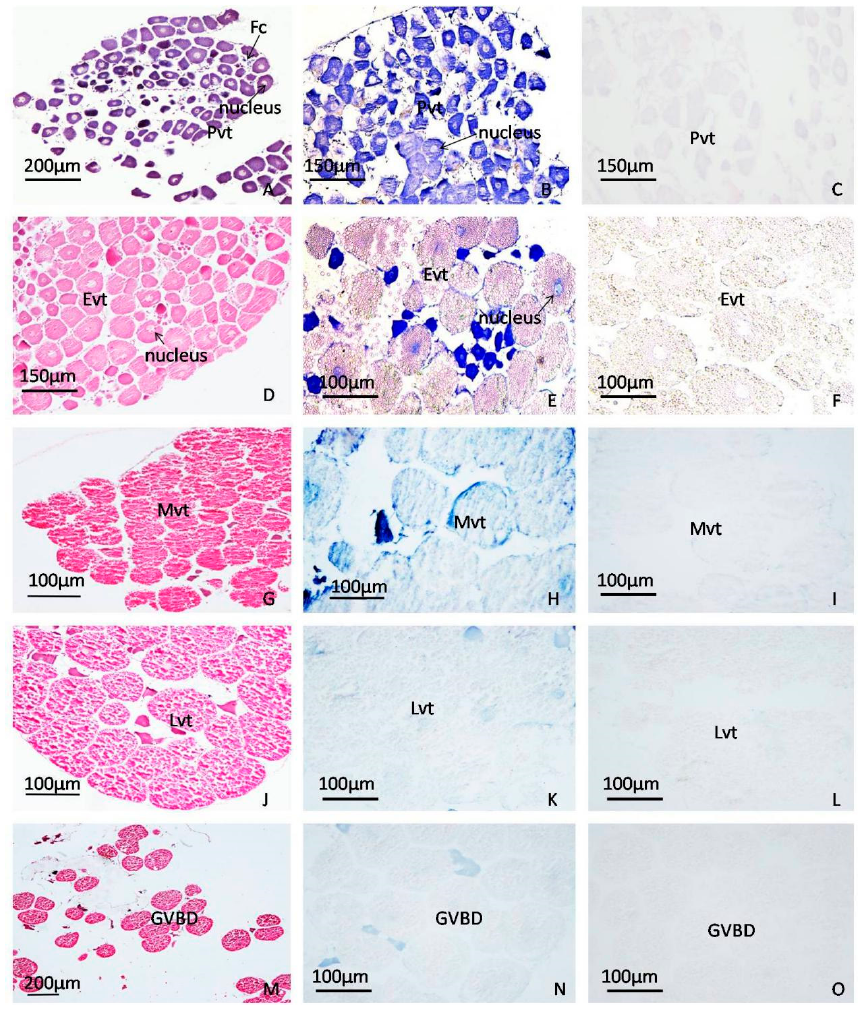
Figure 5. In situ hybridization (ISH) localization of EsLHR mRNA in the ovaries at various stages. ( A – C ), previtellogenic stage (Pvt); ( D – F ), early vitellogenic stage (Evt); ( G – I ), middle vitellogenic stage (Mvt); ( J – L ), late vitellogenic stage (Lvt); ( M – O ), germinal vesicle breakdown stage (GVBD). A, D, G, J, and M, HE staining; B, E, H, K, and N, ISH using antisense probes; C, F, I, L, and O, negative control using sense probes.